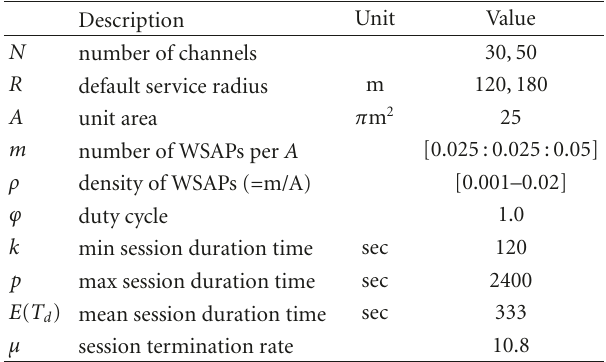
Table 1: Parameters for Evaluation of the Proposed